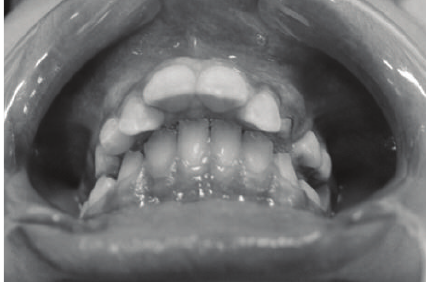
Figure 3: Oral findings revealing marked overjet and skeletal mal- occlusion angle class II, division I.